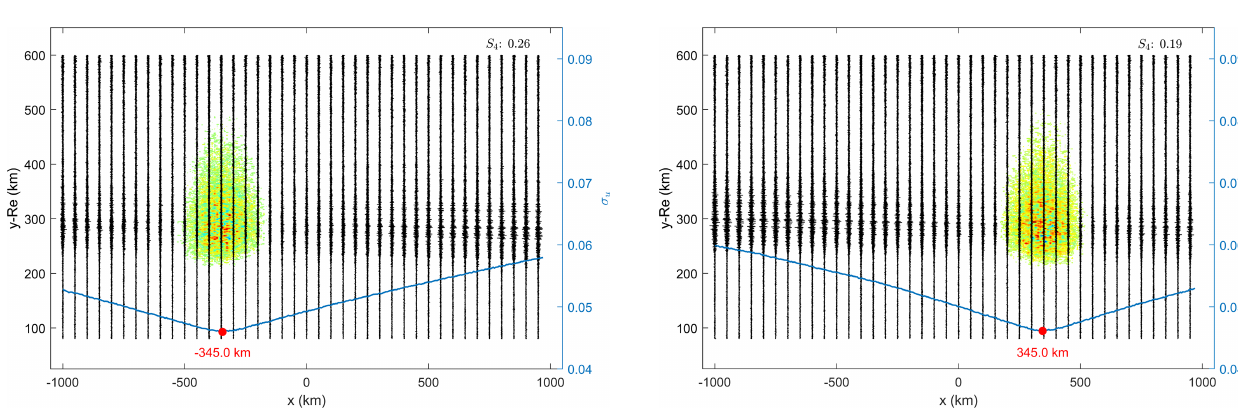
Figure 6. Scenario with a single F-layer bubble in the inbound re- gion. The irregularity region centre is around x ref = − 346 . 7km, as- suming σ (cid:49)ρ/ρ = 17%. Vertical black lines represent the detrended BP amplitudes computed in each auxiliary plane (50km resolution representation). The blue curve corresponds to the detrended BP amplitude standard deviation, computed every 5km. The minimum σ u provides the estimated centre of the irregularity patch. Estima- tion error ε x = − 1 . 7km.